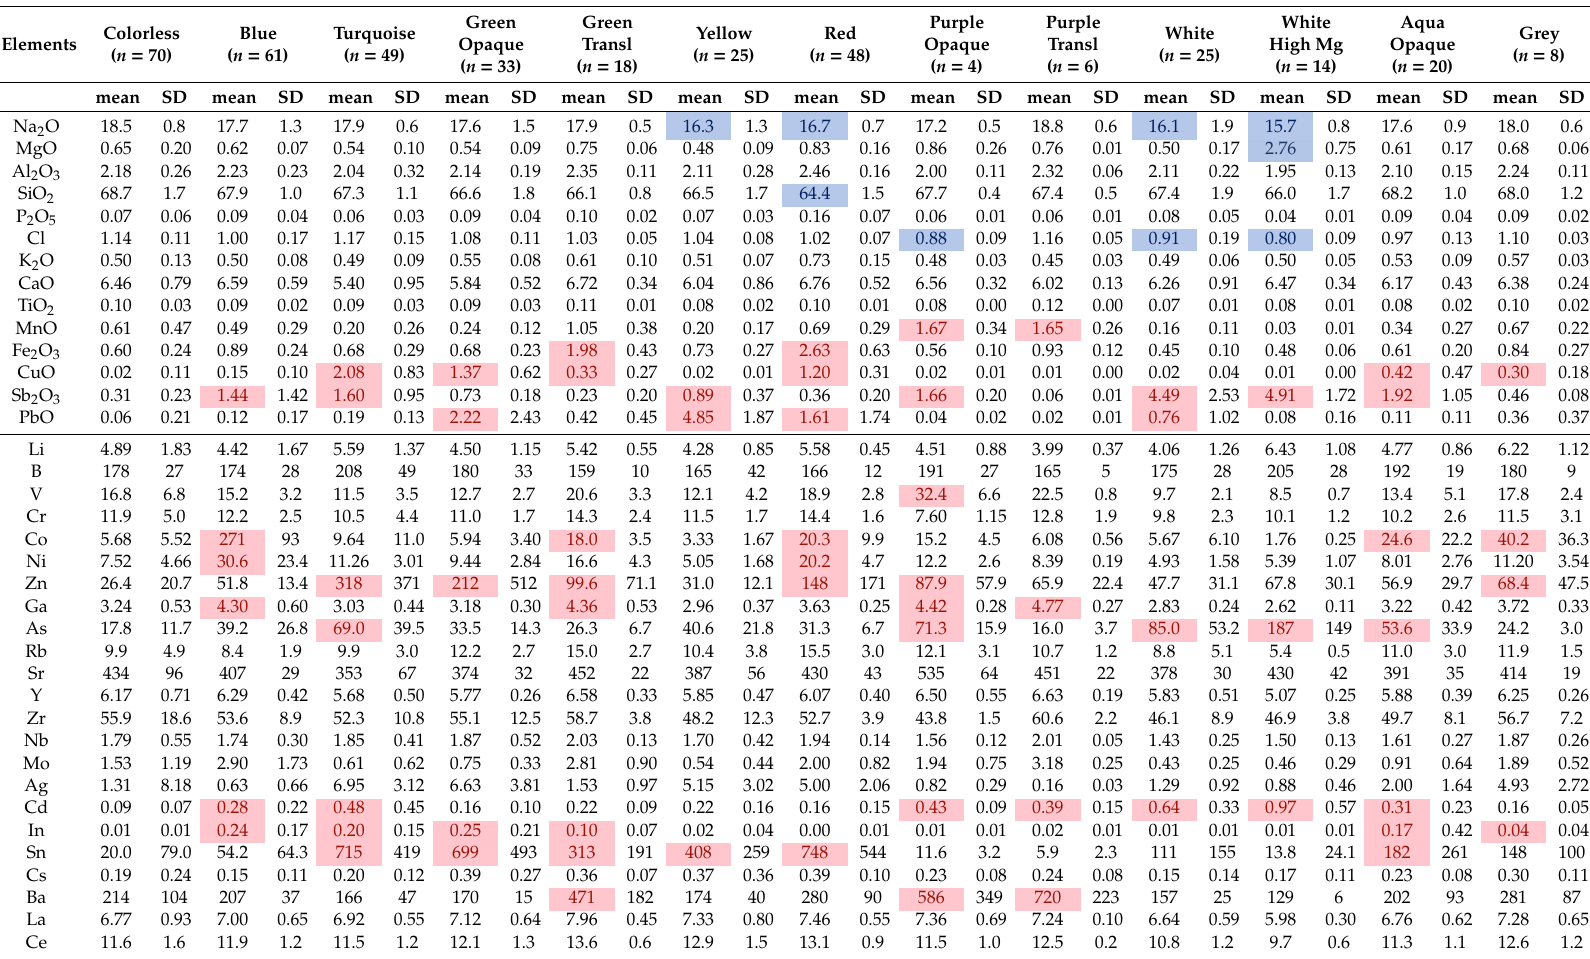
Table 2. Means and standard deviations (SD) of the tesserae from Noheda separated by color. Oxides and chlorine are given as (wt %), while trace elements are given as [ppm]. Elements that di ff er by two standard deviations from the average composition of the gold leaf tesserae are highlighted to indicate their association with the coloring and opacification process (red). Blue indicates di ff erences in the base glass